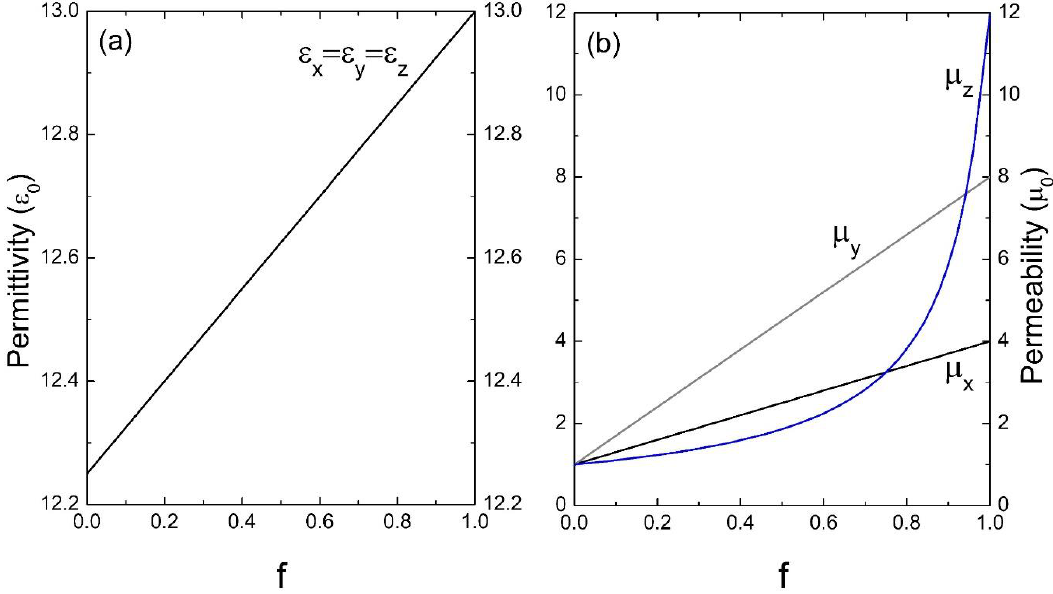
Figure 7. Permittivity ε ( a ) and permeability µ ( b ) versus the filling fraction f ( ε 0 and µ 0 are the units). The parameters used were: ε A = 13 ε 0 , µ Ax = 4 µ 0 , µ Ay = 8 µ 0 , µ Az = 12 µ 0 and ε B = 12.25 ε 0 , µ B = µ 0 .